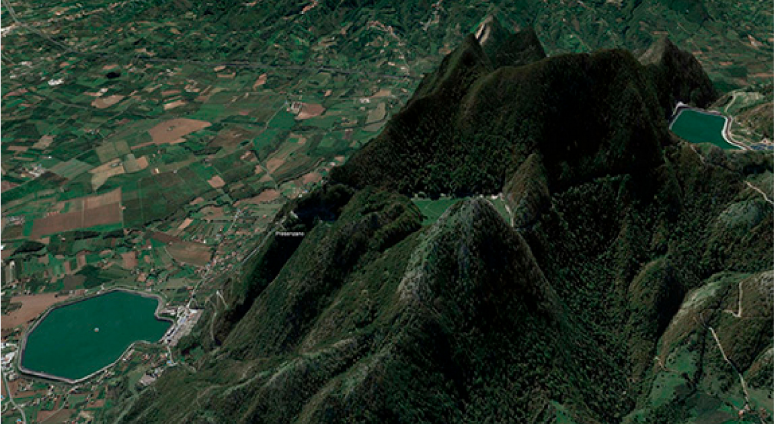
Figure 1. Google Earth synthetic image of a Gigawatt-rated off-river PHES site at Presenzano in Italy, showing the two reservoirs ( upper right and lower left ) with a head of 500 m (vertical scale exaggerated). Map data ©2021